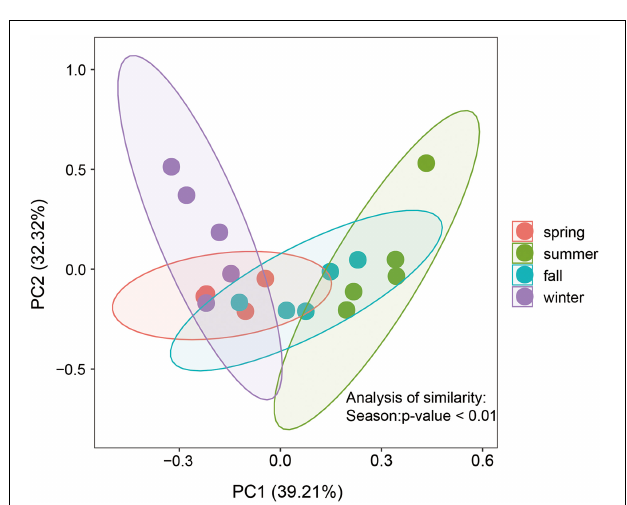
FIGURE 3 | Principal co-ordinates analysis diagram of the Bray-Curtis distance between benthic the diatom community for all